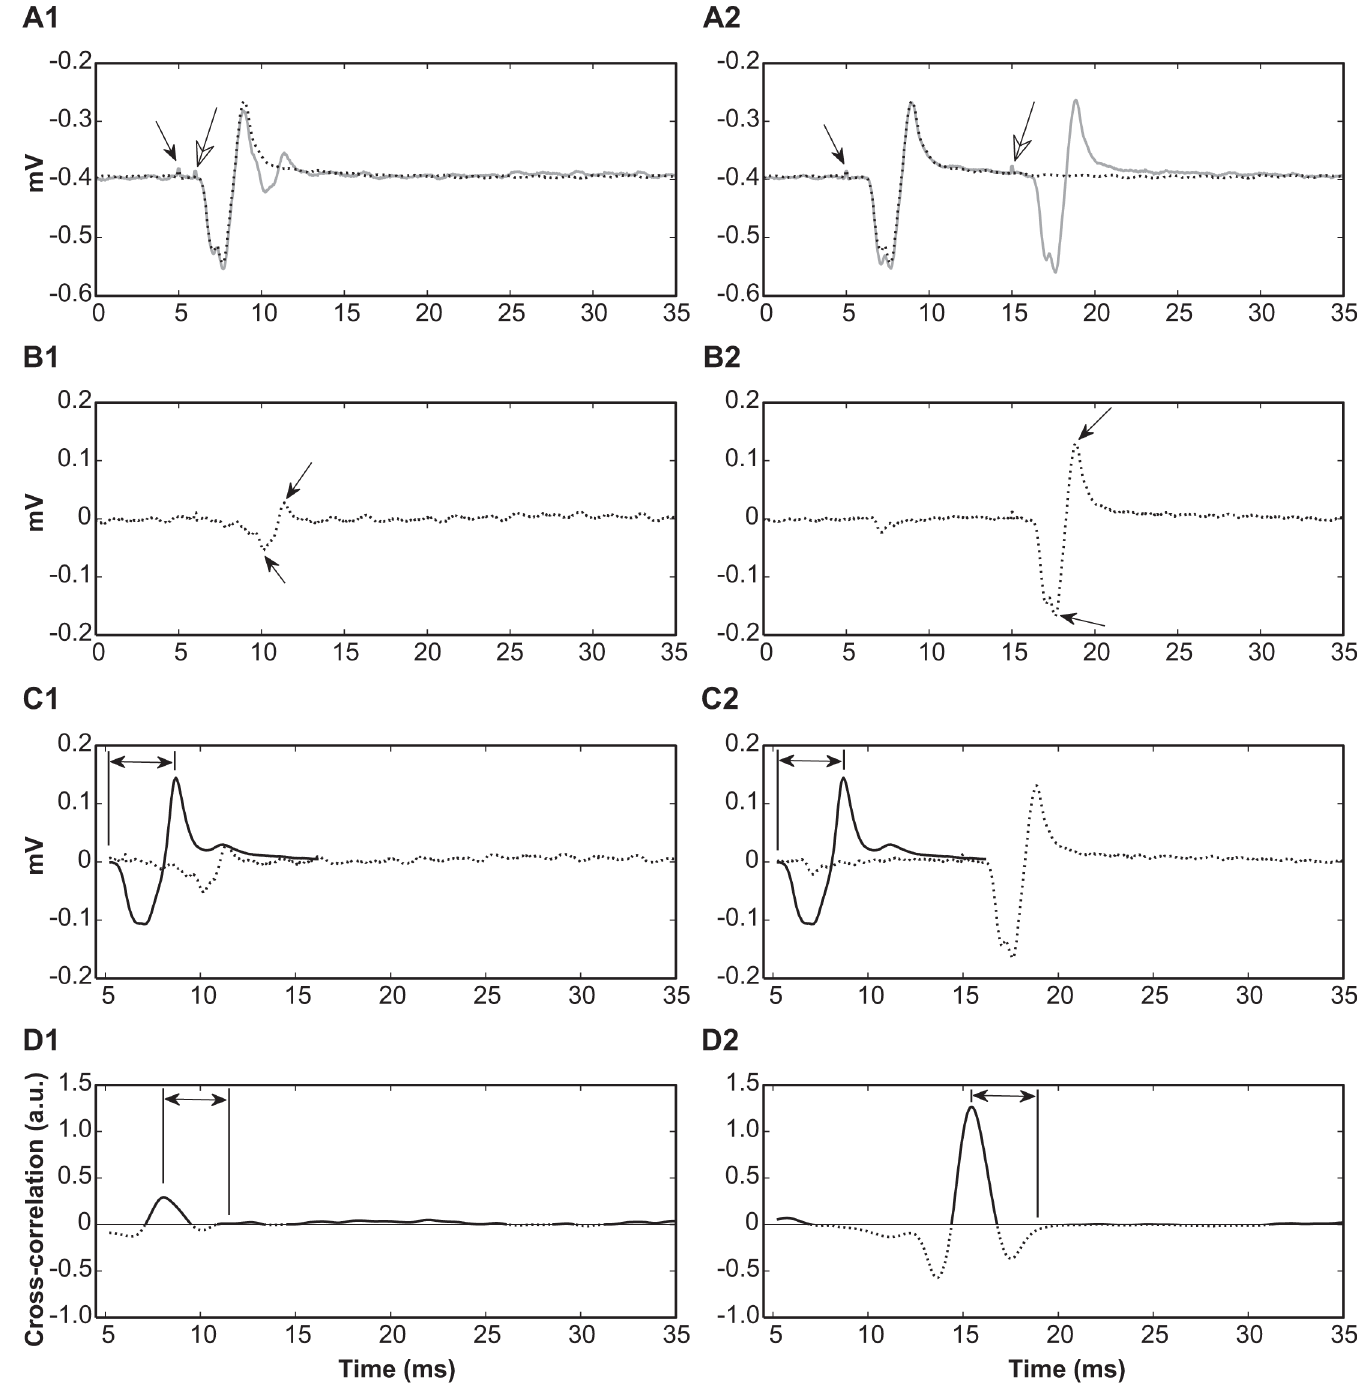
Fig 4. Pre-processing and quantification of CMAP responses by WSA and TEA. Shown are examples of paired conditioning (black arrow, row A) and test (white arrow, row A) stimuli presented to an intact sciatic nerve, with inter-pulse intervals of 1 ms (column 1) and 10 ms delays (column 2) of the same animal. First, an average of 2 repeated M5avRs were evoked by a single conditioning pulse stimulus (0.7 mA 0.2 ms) at 5.0 ms after the onset of the recording sweep (black arrow, row A) in the absence of a following test pulse. This average trace (dotted traces, row A) was subsequently subtracted from each M5avR evoked by the paired stimuli (grey traces, row A) to reveal the response to the test pulse in the absence of the conditioning pulse (row B), and subsequently quantified by TEA (peak-to-peak, arrows, row B) and WSA methods (rows C and D). The template comparing wave, M-template (black trace, row C) was slid across the pre-processed M5avR (dotted trace, row C) to derive the cross-correlation function between the M-template and the pre- processed M5avR signals at each time instant (row D, positive cross-correlations black, negative cross-correlations dotted). Positive peak values of the